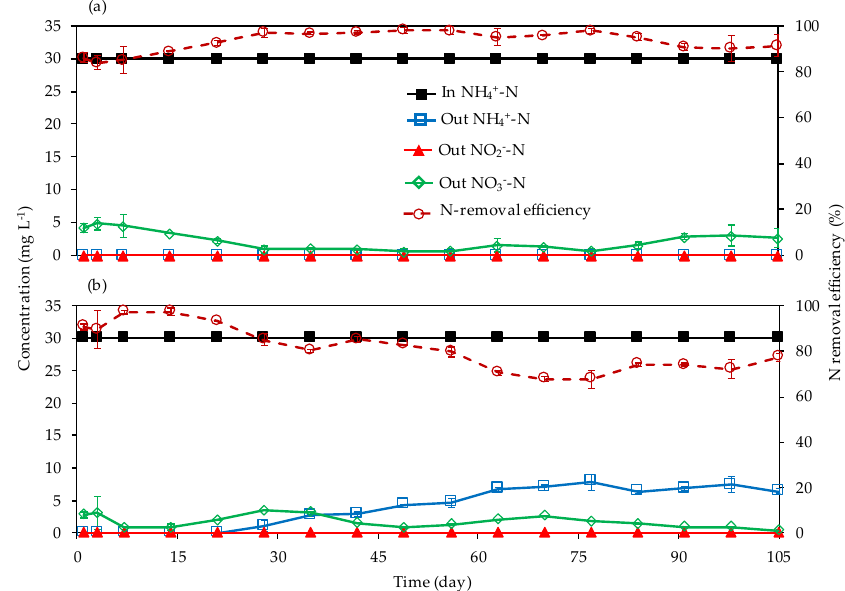
Figure 2. Changes in NH 4+ -N, NO 2‒ -N, and NO 3‒ -N concentration and N removal efficiency over 105 days of CW operation in ( a ) tidal flow, and ( b ) continuous flow. Values are means ± SD (n = 2).